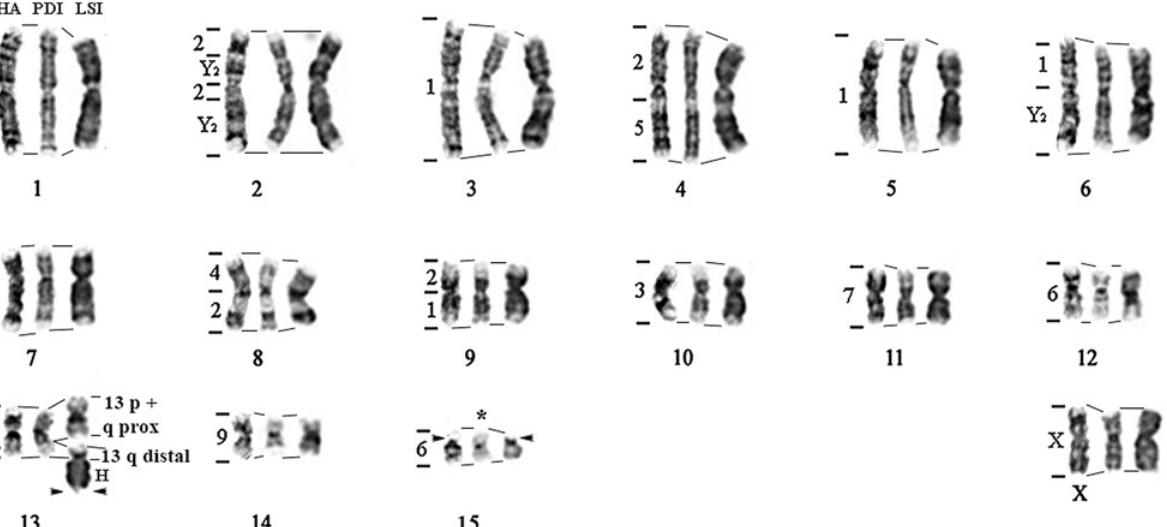
Fig 5. Comparative analysis using G-banded chromosomes of PHA, PDI and LSI. H = constitutive heterochromatin; NOR = Nucleolar Organizer Regions; * Pericentric inversion of pair 15 of PDI to PHA and LSI. Numbers on left: chromosomes from Carollia brevicauda . Numbers below: chromosomes from Phyllostomus hastatus .